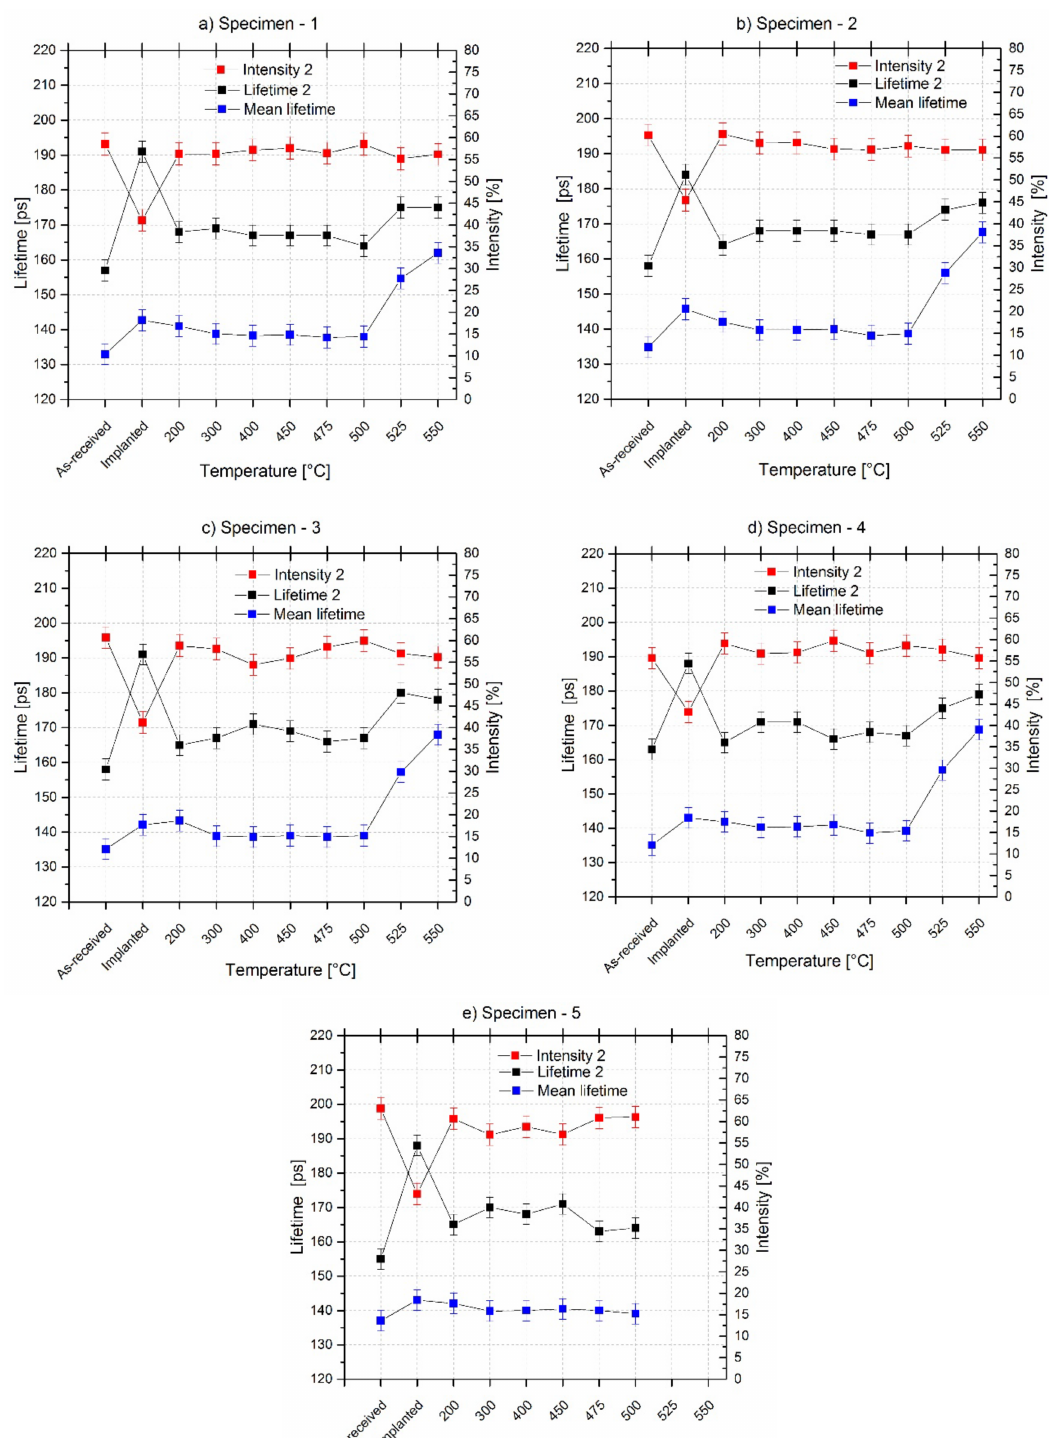
Figure 7. PALS data for as-received, implanted, and annealed specimens: Lifetime 2 proportional to the size of the defects; Intensity 2 proportional to defect concentration; and Mean lifetime describing the defect presence in the